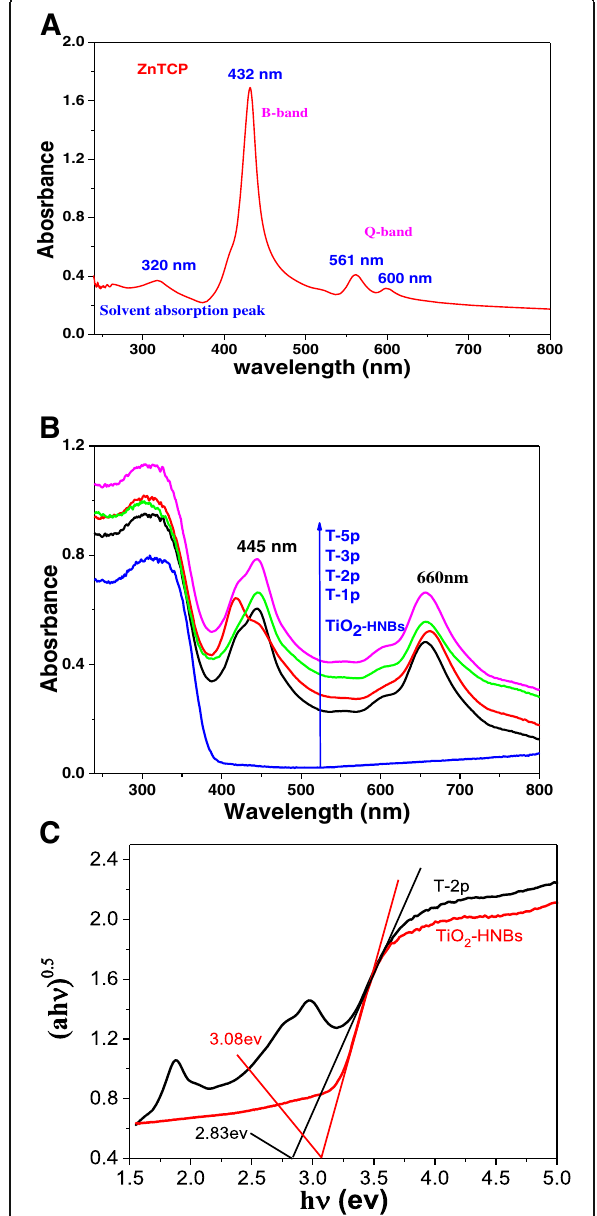
Fig. 5 a UV-Vis spectra of ZnTCP in 5×10 − 4 mol/L DMF solution. b UV-vis diffuse reflectance spectra (DRS) of all the samples. ( c ) Estimated optical absorption edges for the T-2p and TiO2-HNBs